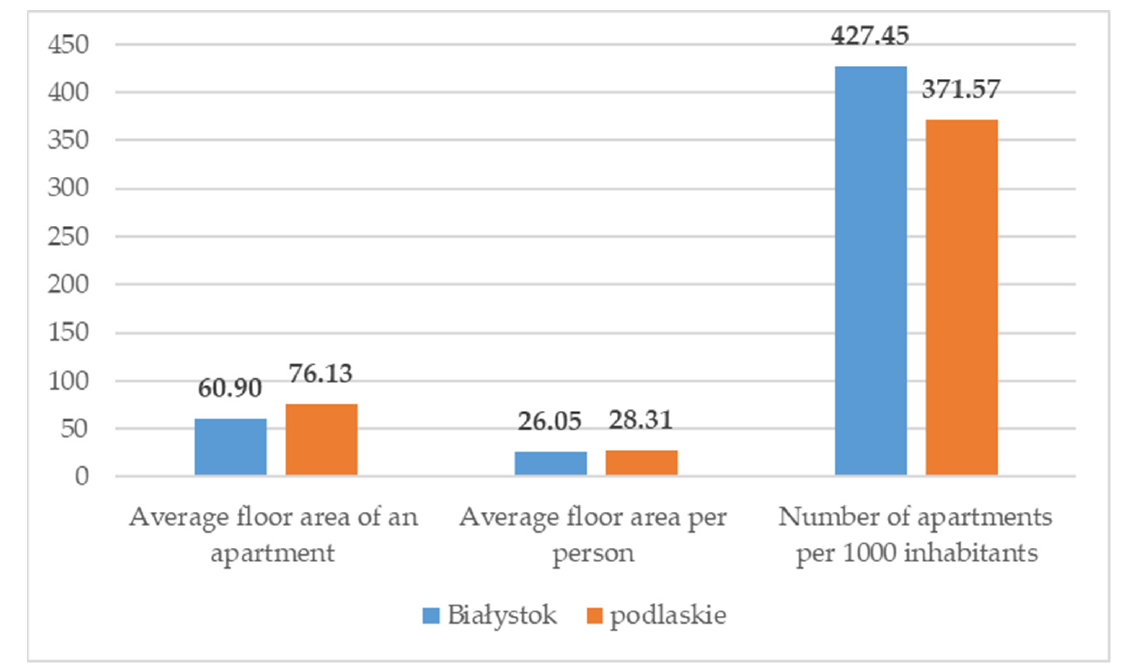
Smart Cities 2022 , 5, FOR PEER REVIEW Figure 2. Indicators of housing infrastructure availability in Bia ł ystok and the Podlaskie Province. Figure 2. Indicators of housing infrastructure availability in Białystok and the Podlaskie Province.